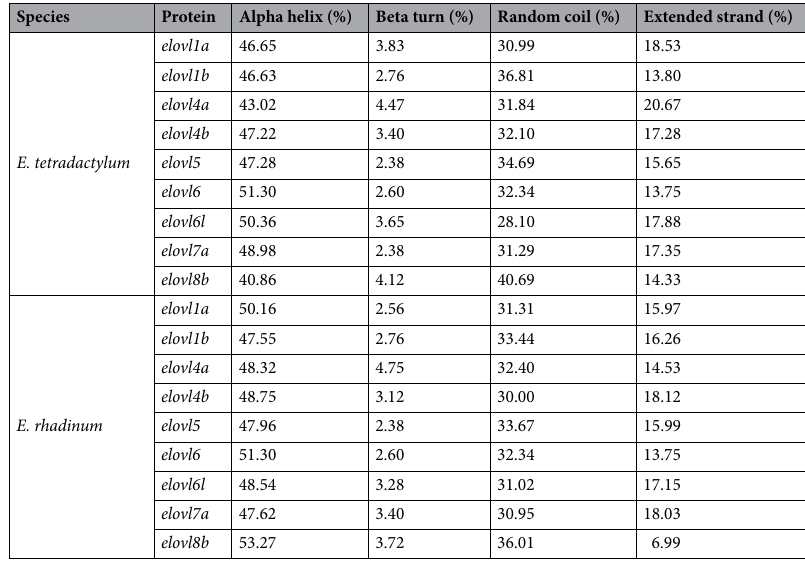
Table 3. Properties of the secondary structures of Elovl proteins.